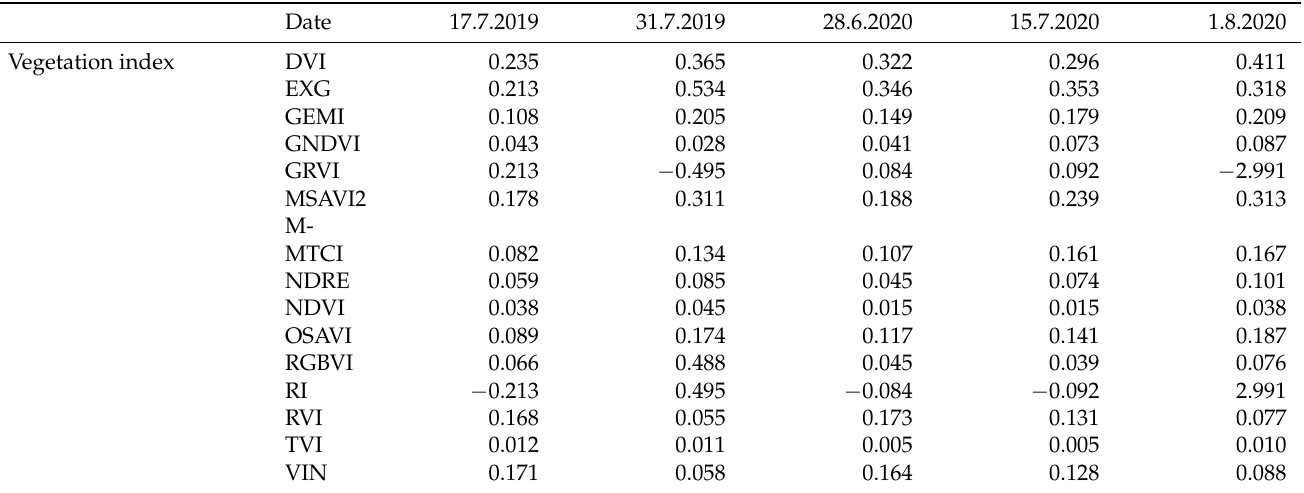
Table 3. Coefficient of variation value for each vegetation index for every measurement day; 28 June had nine measurement points from which the coefficient of variation values were calculated. The other measurement days had ten